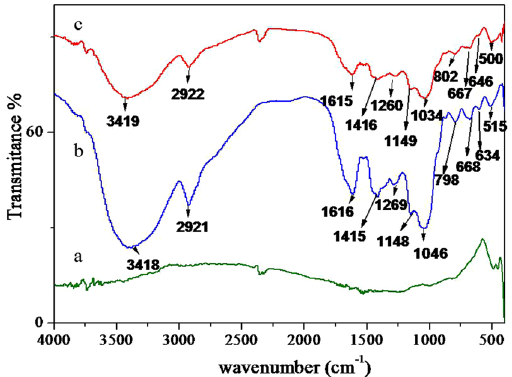
Figure 4. FT-IR spectra of ( a ) GnPs; ( b ) Danshen tablets; ( c ) GnPs-Danshen tablets.